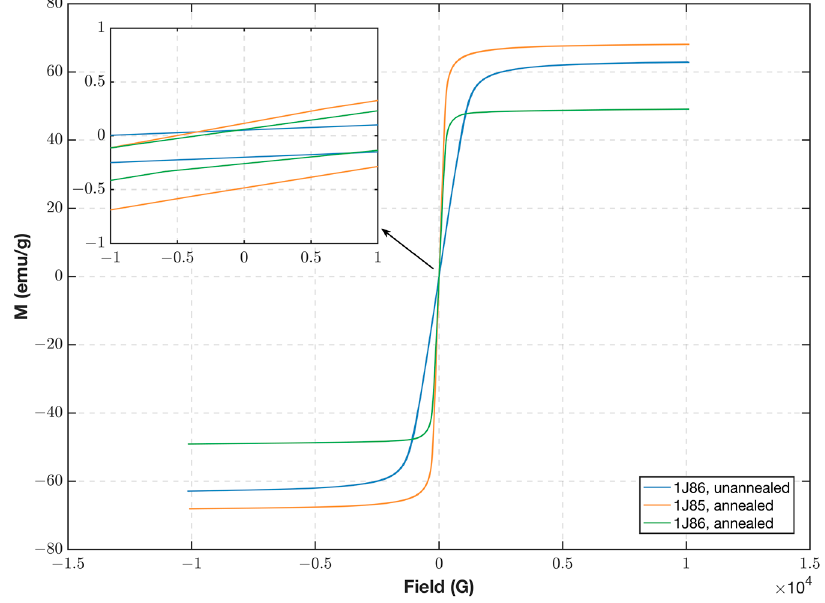
Figure 5. Measured hysteresis of different annealing core materials.